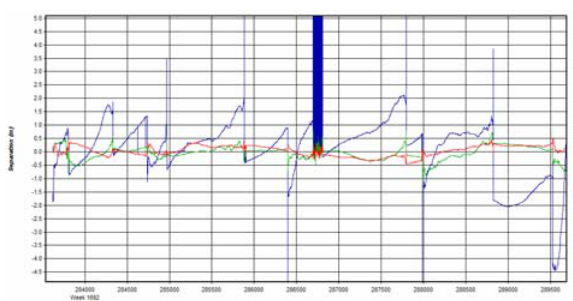
Figure 3. Distribution of networks